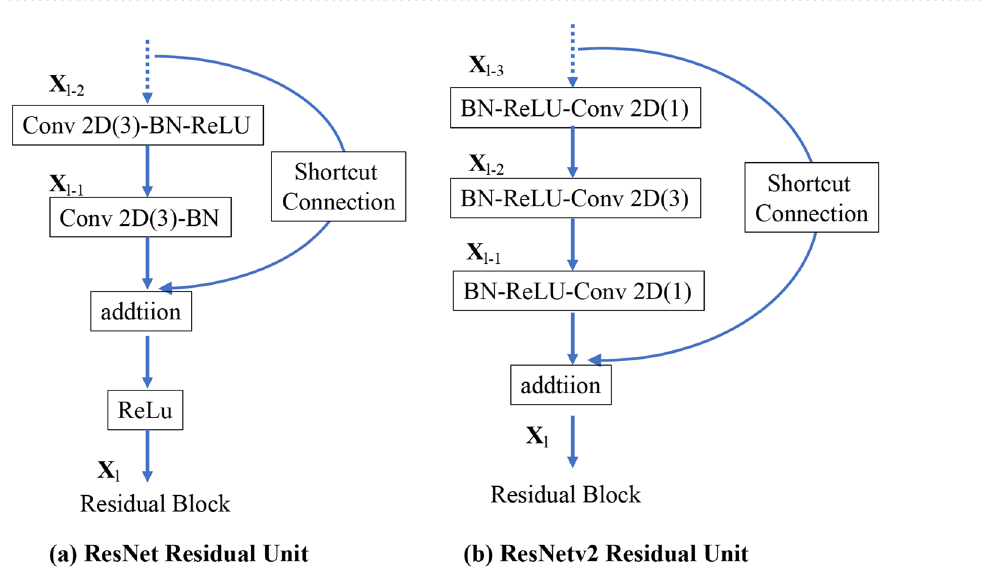
Figure 2. Differences between the residual blocks of ResNet and ResNetv2: ( a ) ResNet Residual Unit; ( b ) ResNetv2 Residual Unit. BN: Batch Normalization and Conv2D: Two-dimensional convolution